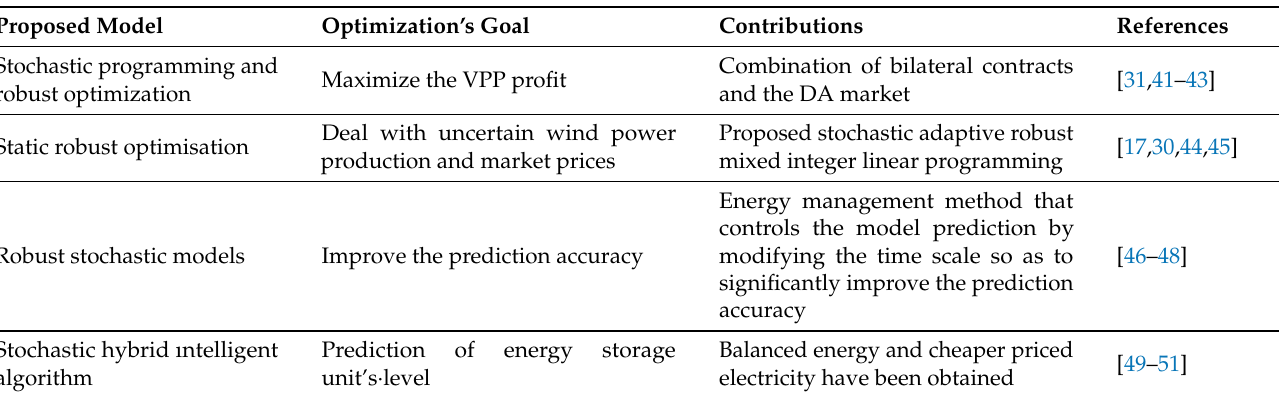
Table 1. Programming models on